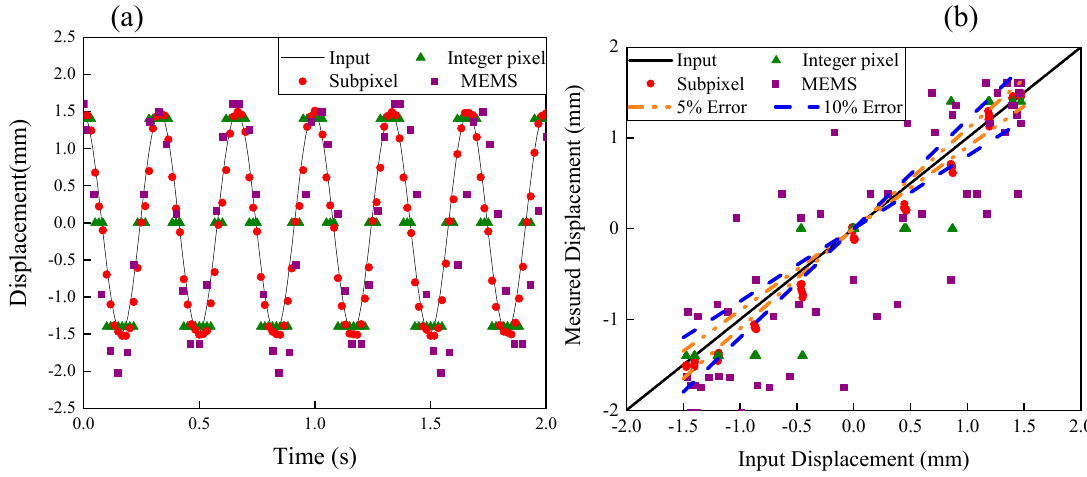
Figure 8. ( a ) Comparison of captured displacement data with input sinusoidal function with frequency of 3 Hz and amplitude of 1.5 mm and ( b ) Error analysis.